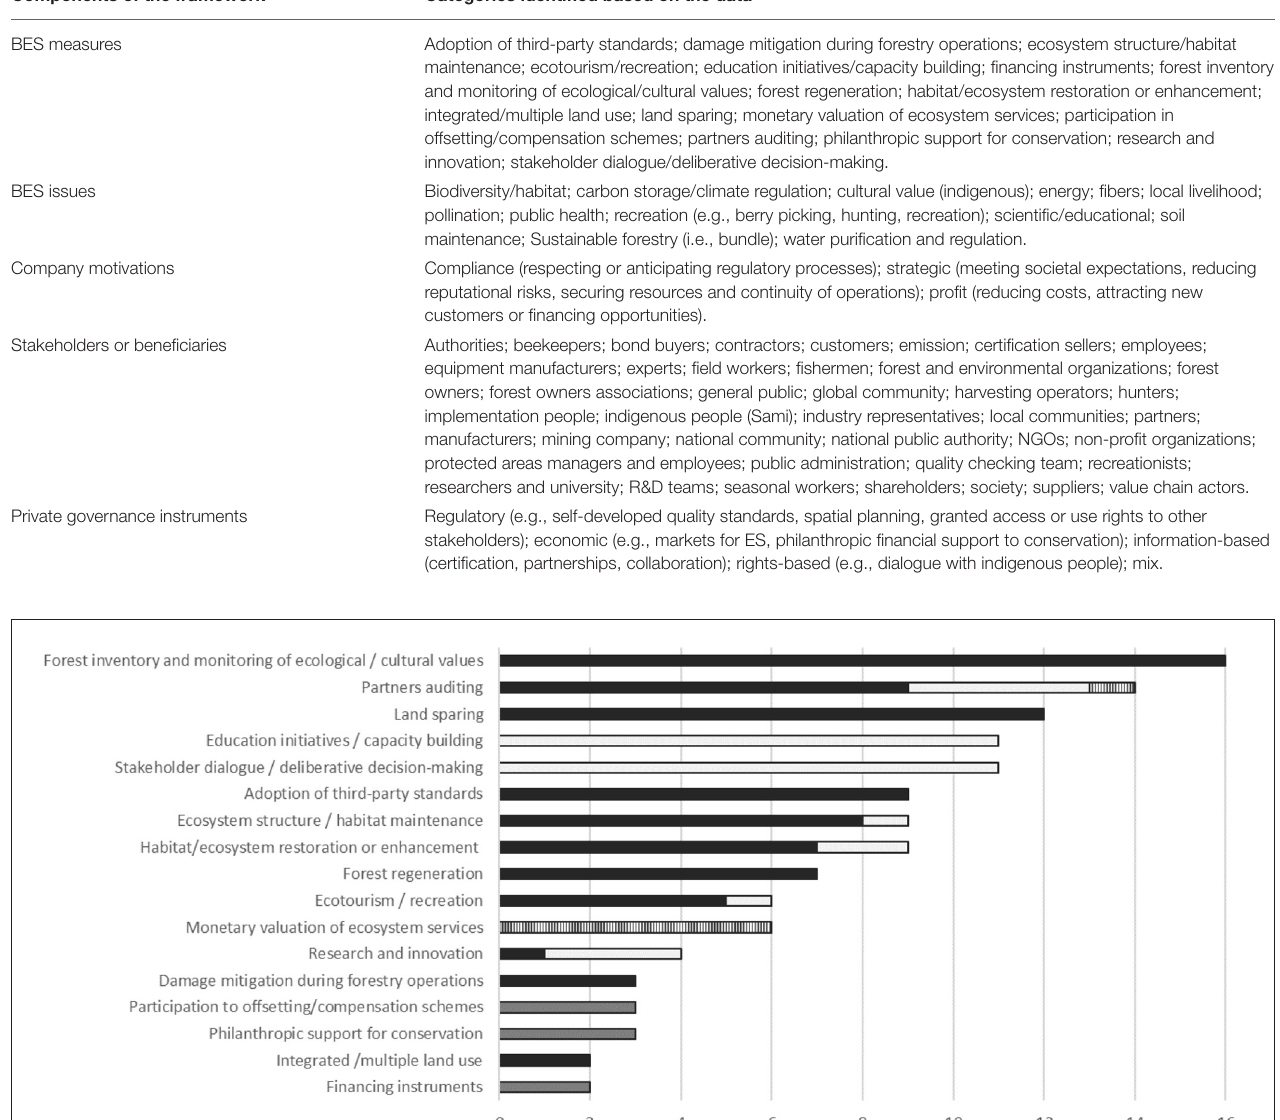
TABLE 4 | The framework used in this study to investigate private governance of BES. Components of the